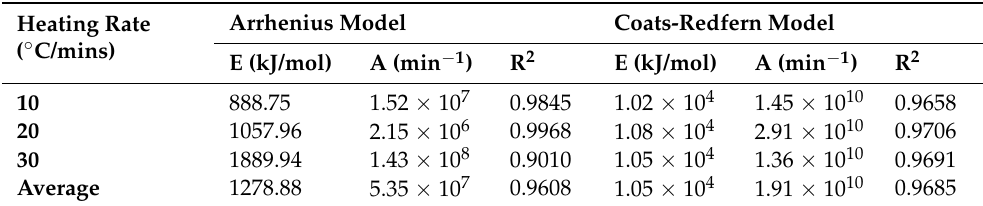
Table 4. Arrhenius and Coats-Redfern kinetic parameters of PET MPs degradation at different heating